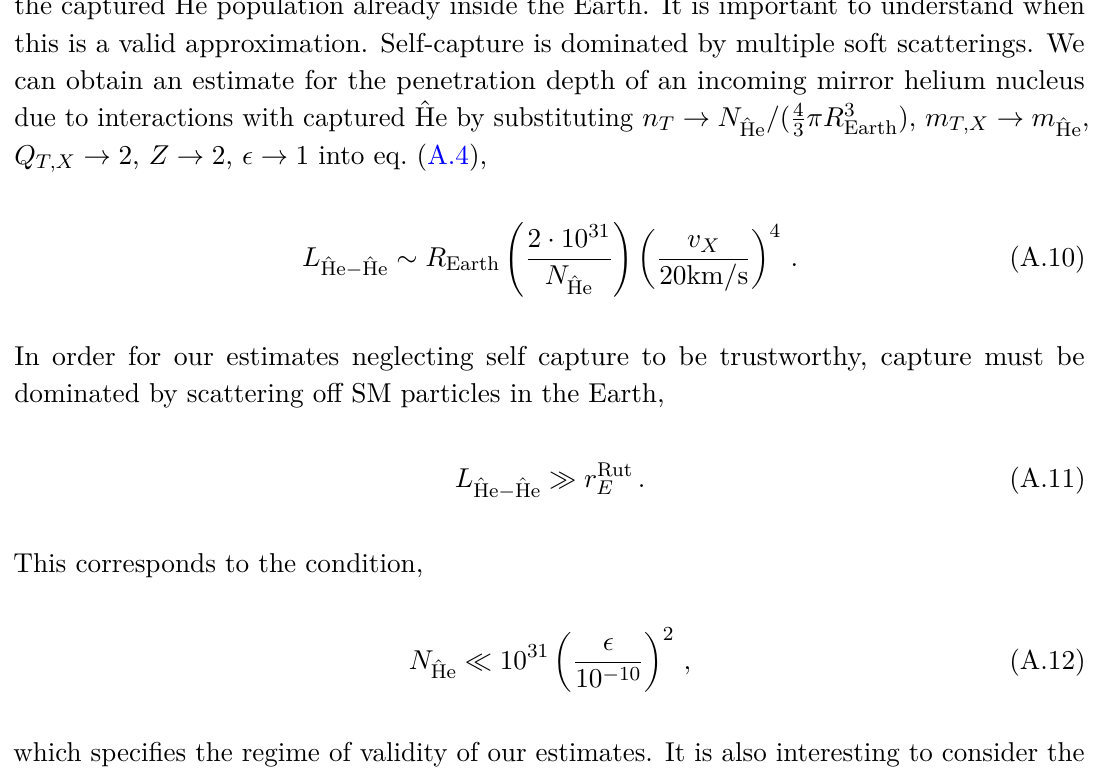
Figure 7 . Mirror helium capture rates from multiple soft scattering (solid) and single hard scattering (dashed) processes as a function of the kinetic mixing parameter (cid:15) for r that the net mirror charge of the Earth is small, so that its effect on the escape velocities of mirror particles is